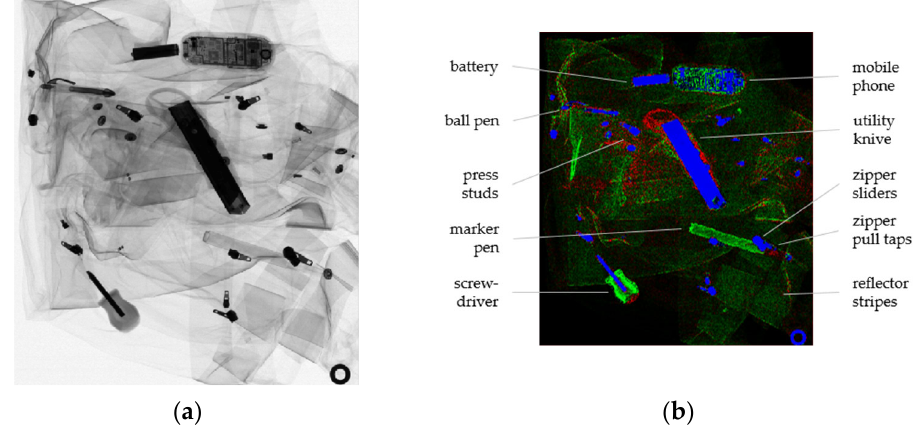
Figure 6. ( a ) High-energy image of the paramedical jacket. ( b ) False-colored combination of material images; red indicates Z eff = 6 (plastics), green indicates Z eff = 11 (sodium), and blue indicates Z eff = 26 (iron). As the second basis material, Z eff = 7.1 was used in all cases.